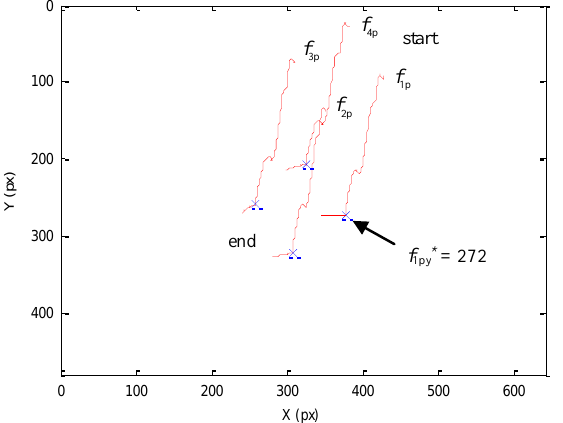
Figure 9. Trajectory of the visual features extracted by the camera at the end of the mini-robot during the second experiment.